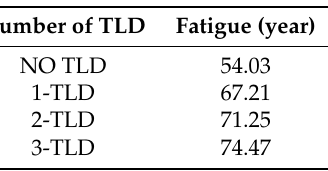
Figure 32. The histogram of stress rainflow counting of uncontrolled OWT and controlled OWT with difference numbers of TLDs. Table 7. Fatigue life of using various TLDs.